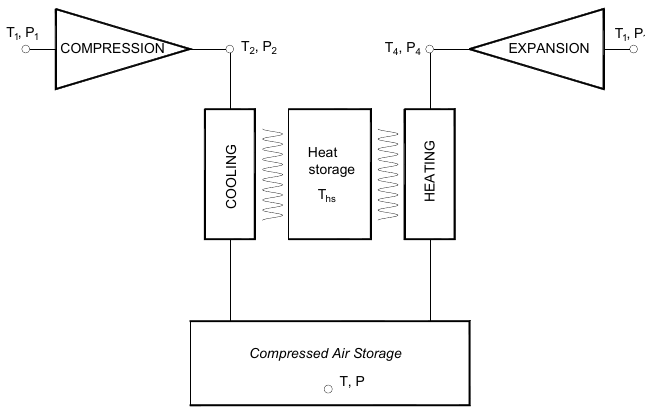
Figure 1. Thermodynamic processes of compressed air energy storage (CAES) (modified from [7]).